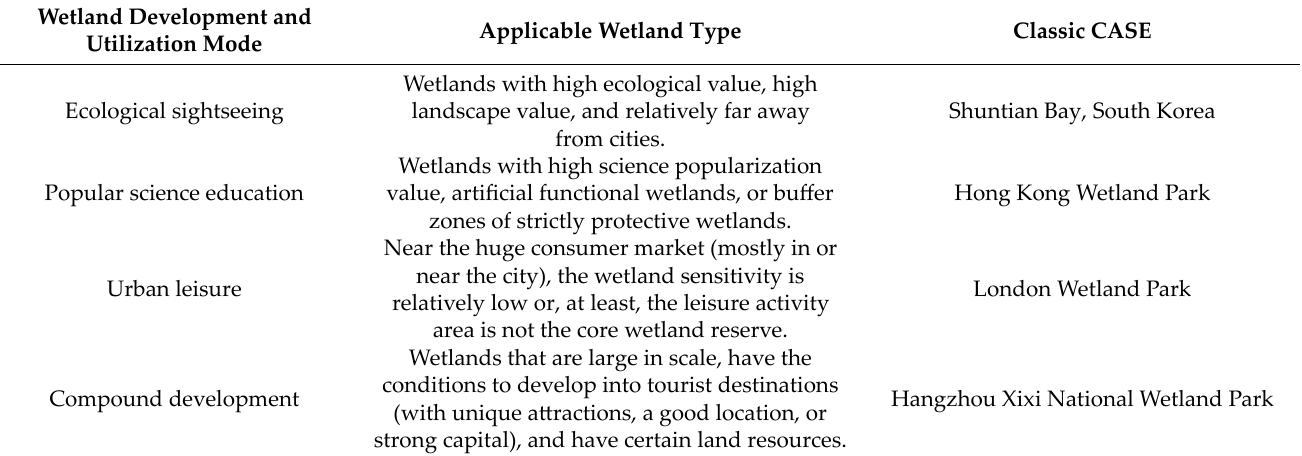
Table 2. Typical wetland development and utilization